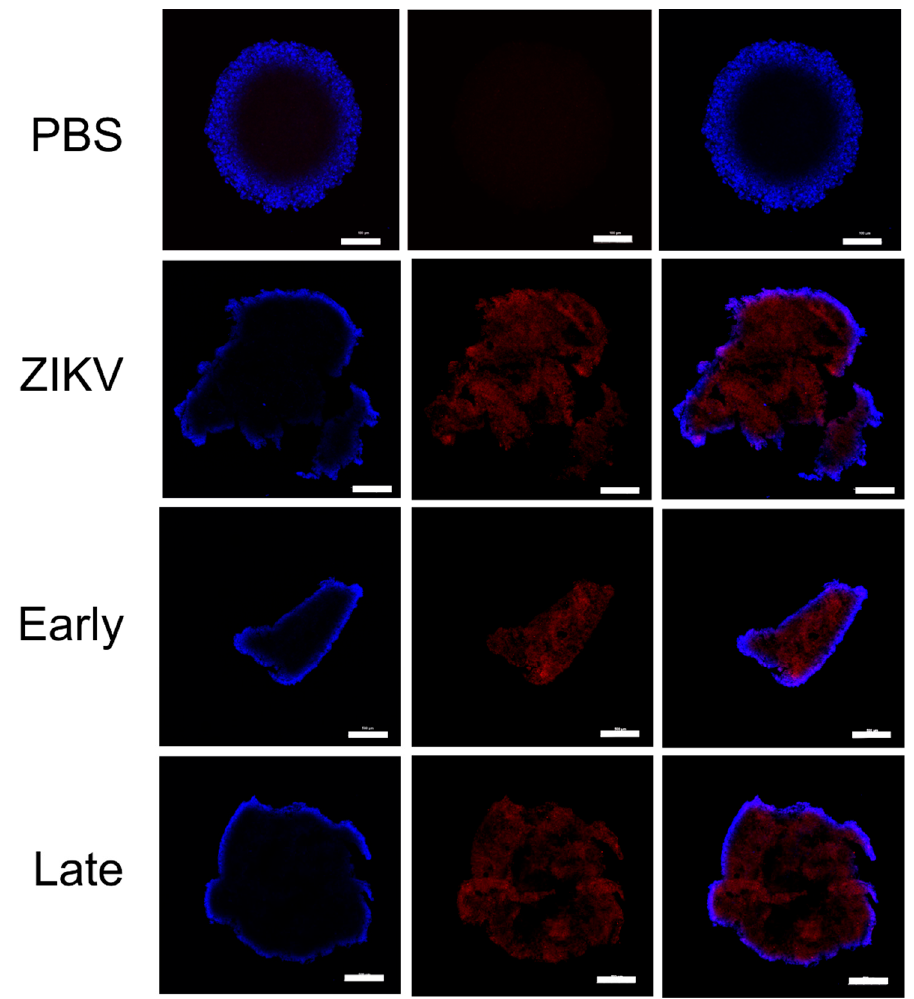
Figure 7. Immunofluorescence of EBs (blue = DAPI, red = ZIKV–4G2). EBs were stained with D1-4G2-4-15 antibody and mounted on glass slides. Coverslips were pressed down on the EBs to flatten them, producing a ring effect in most images. Images were obtained under 4× magnification. Scale bar represents 100 µM.